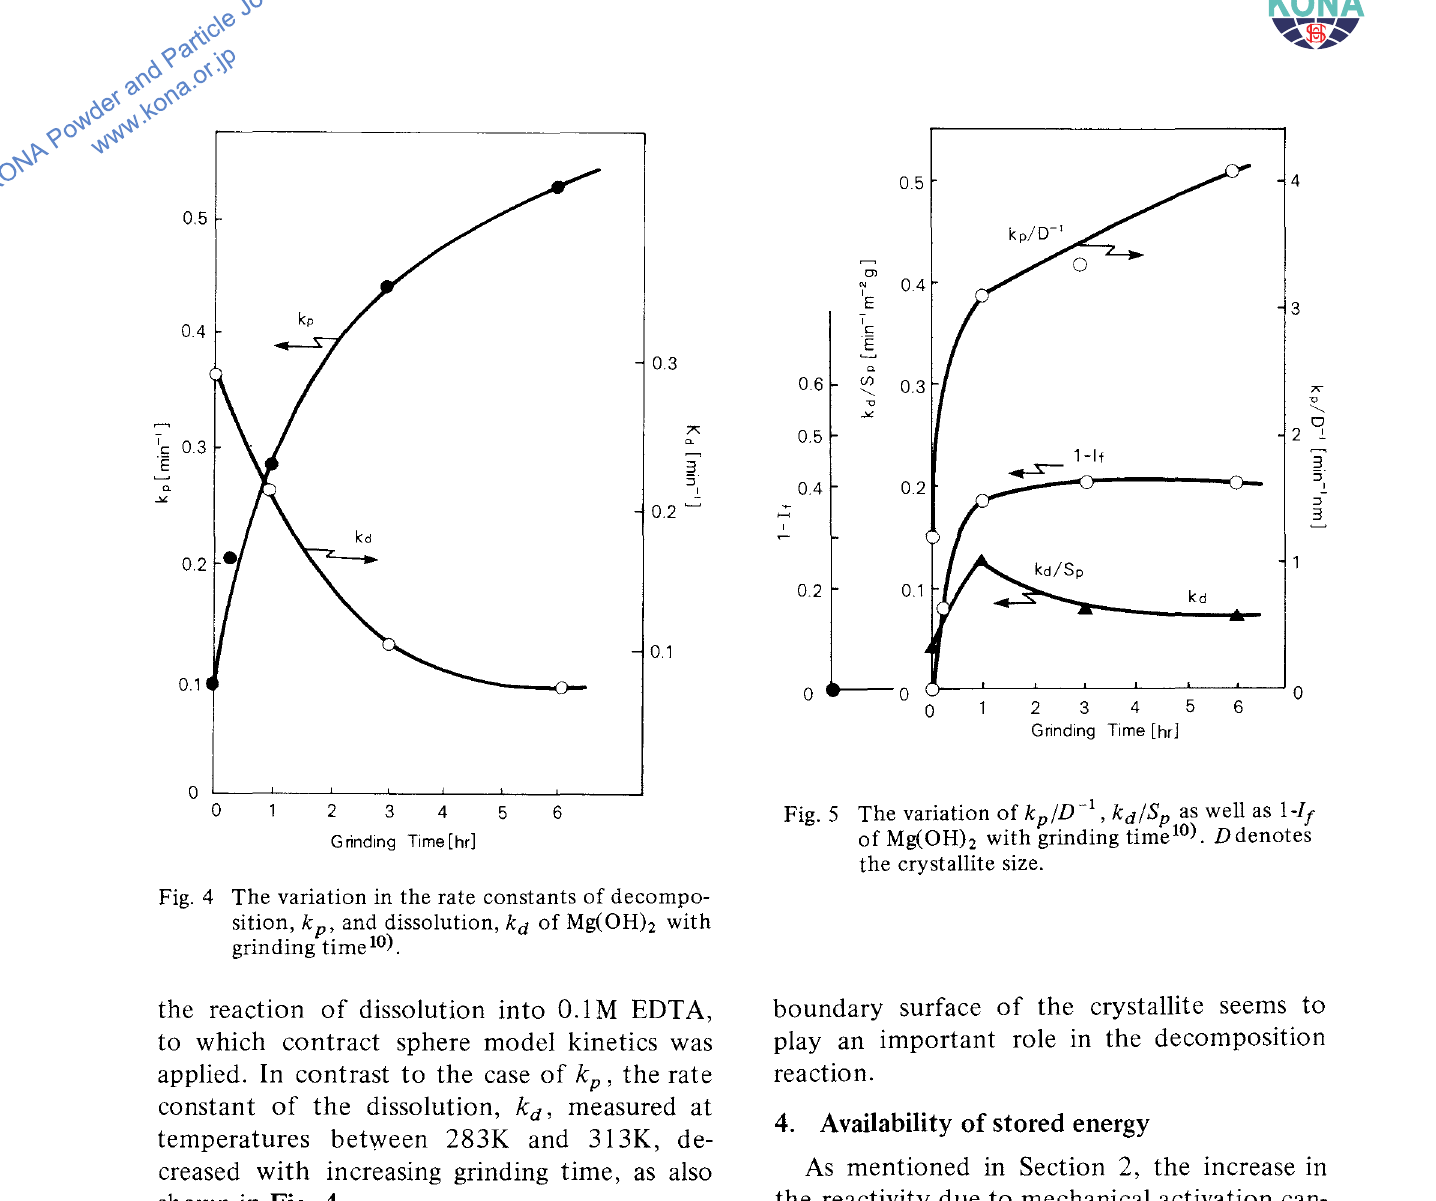
Fig. 5 The variation of kp/D- 1 , kd/Sp as well as 1-lt of Mg(OH)z with grinding time 10). Ddenotes the crystallite size.